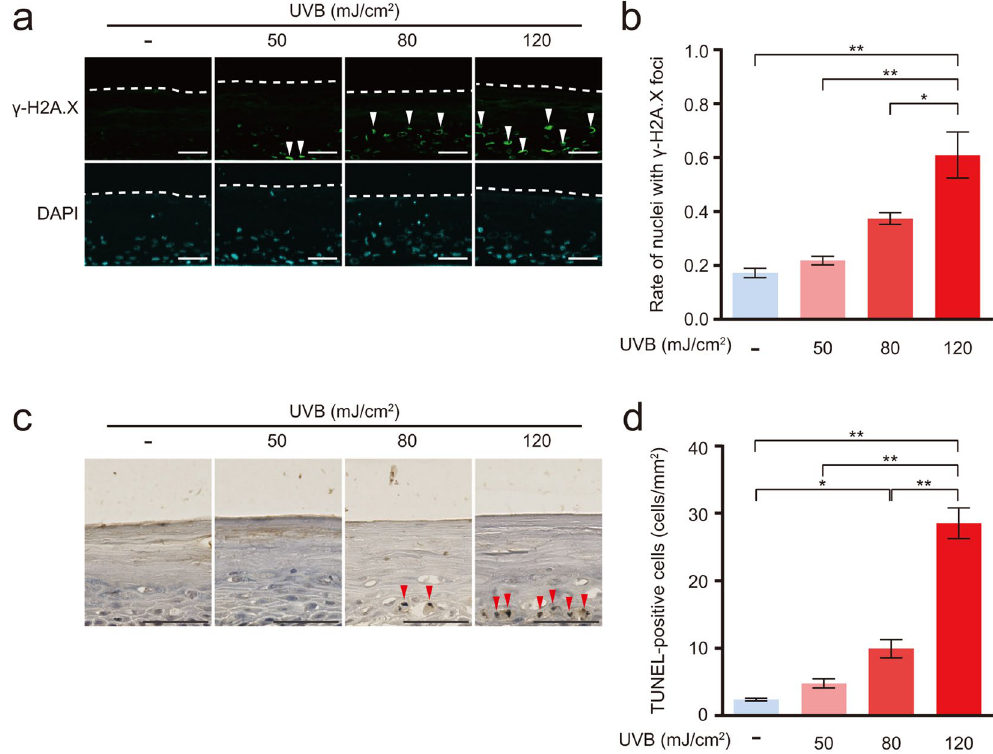
Figure 3. UVB induced DNA damage and apoptosis in the reconstituted human epidermis. The reconstituted human epidermis was irradiated with 50, 80 or 120 mJ/cm 2 UVB. After UVB irradiation, the epidermis was cultured for 24 h. ( a ) Immunofluorescence staining for γ -H2A.X as a marker of DNA double-strand breaks. The dotted line represents the bottom of the cornified layer. White arrowheads indicate γ -H2A.X-positive nuclei. Bar = 50 µ m. ( b ) The percentage of γ -H2A.X-positive nuclei per DAPI-positive nuclei. Values are presented as the means ± SEM of three wells. ( c ) Apoptotic cells were detected by TUNEL staining. Red arrowheads indicate TUNEL-positive cells. Bar = 50 µ m. ( d ) Number of TUNEL-positive cells under the cornified layer. Values are presented as the means ± SEM of three wells. The statistical analysis was performed using one-way ANOVA followed by Tukey’s post hoc test. * P < 0.05, ** P <